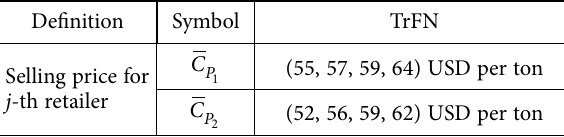
Table 3. Selling price for each retailer